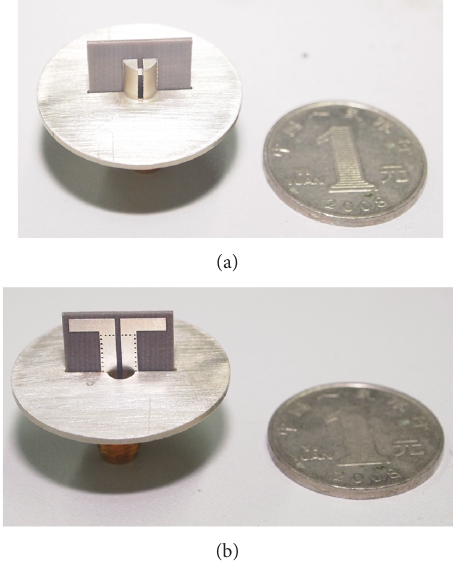
Figure 12: Photo of the fabricated antenna.